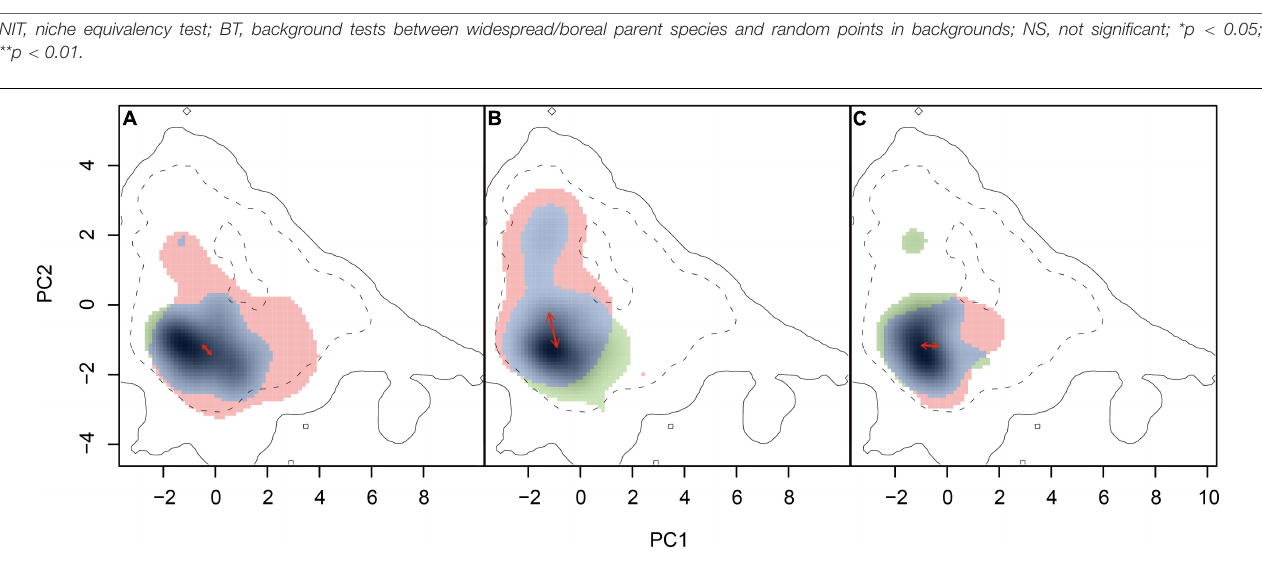
species and between Ranunculus species was higher